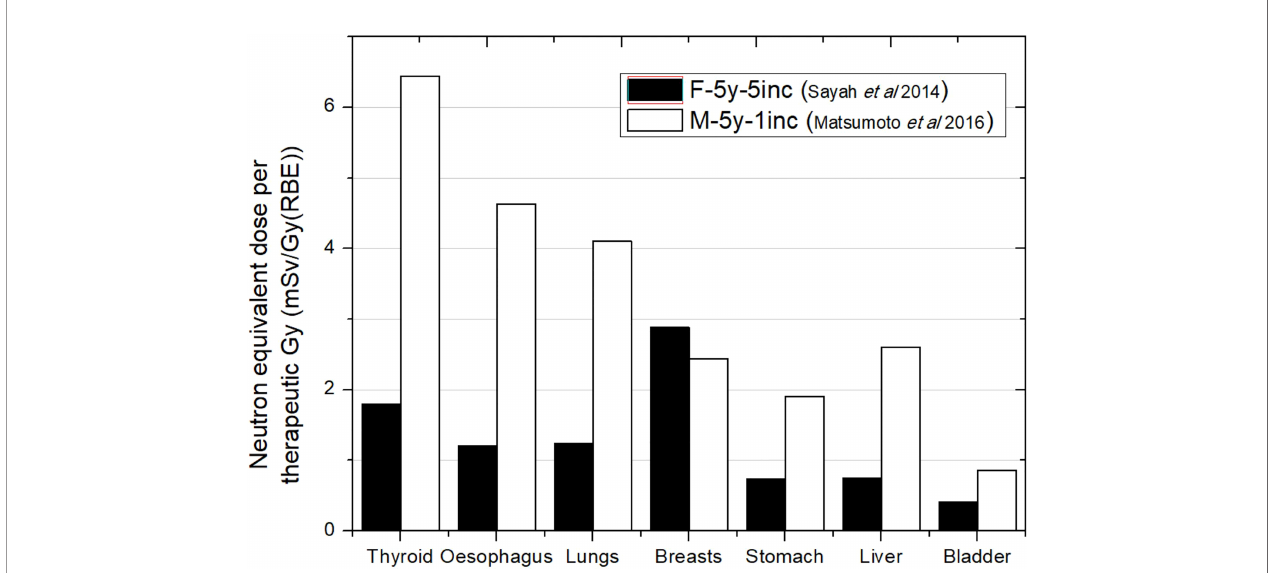
FIGURE 2 | Neutron equivalent doses per therapeutic Gy in selected organs for a brain treatment in two different passive scattering proton beam facilities. Data extracted from Matsumoto et al. (31) and Sayah et al. (34) for the same age phantom (5 years) but different target volumes and number of incidences: 83 cm 3 in Matsumoto et al. (31) and 92 cm 3 in Sayah et al. (34). In the legend, the sex (F, female; M, male), age of the patient (#y = number of years), and number of incidences (#inc = number of incidences) are speci fi ed.